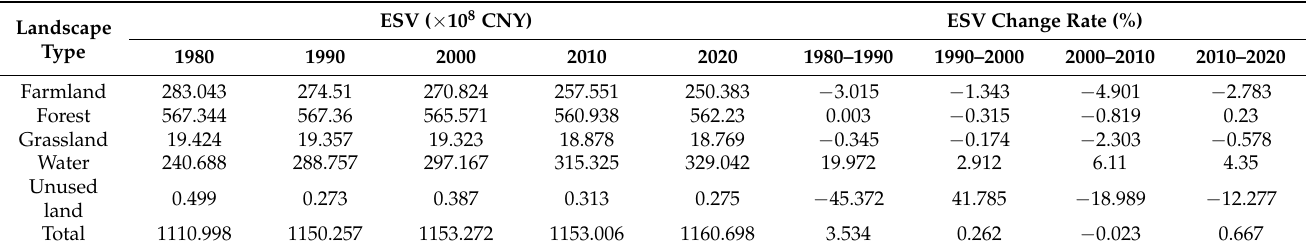
Table 5. Changes in ecosystem service value of the six land cover types during 1980–2020.